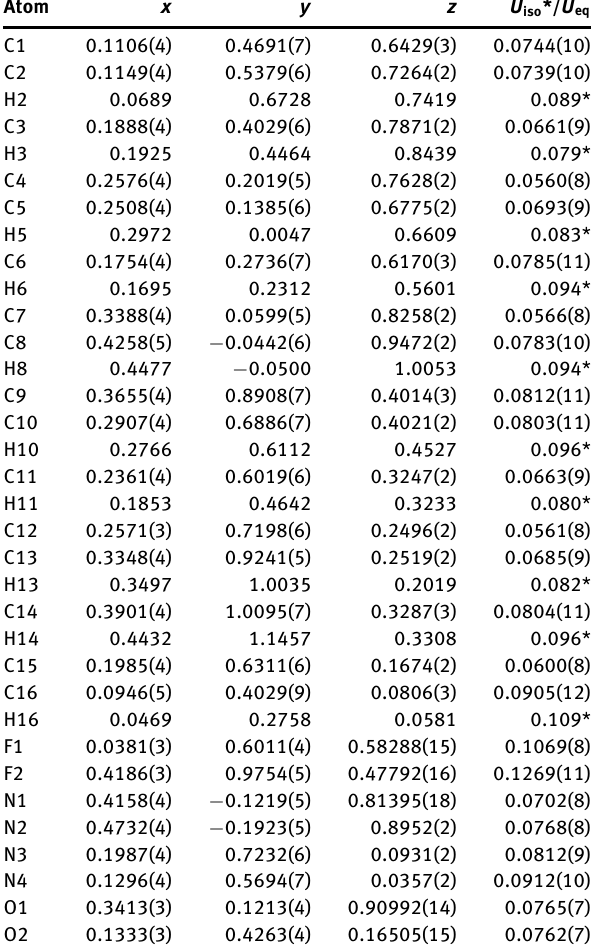
Table 2: Fractional atomic coordinates and isotropic or equivalent isotropic displacement parameters (Å 2